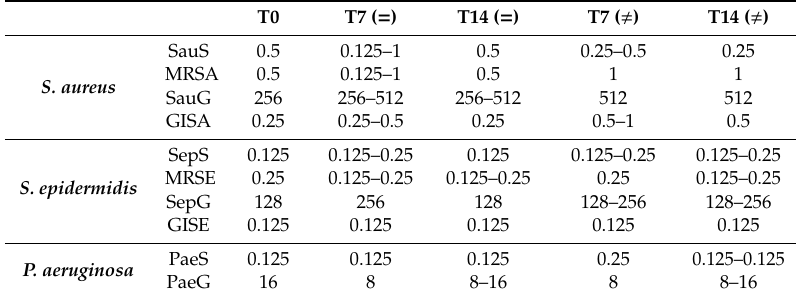
Table 2. Resistance profile of the tested strains to gentamicin before (T0) and after (T7) exposure to CG and after cycle on antibiotic-free medium (T14). Numbers indicate gentamicin concentrations ( µ g / mL). ( = ), exposure to the same CG disc; ( (cid:44) ), exposure to a fresh CG disc. T0 T7 ( = ) T14 ( = ) T7 ( (cid:44) )